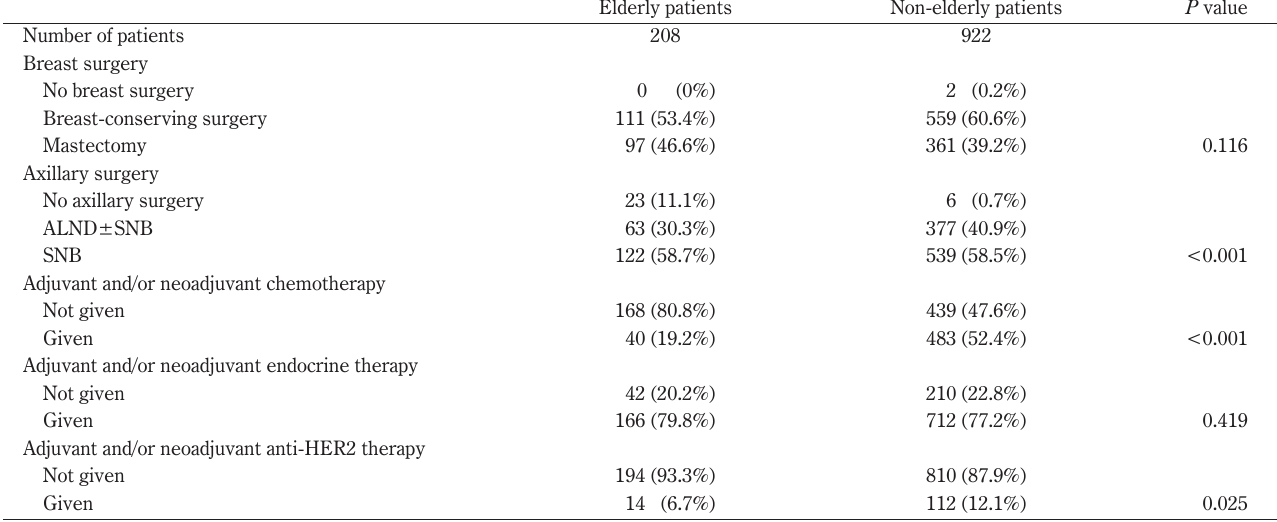
Table 3 Patient treatments